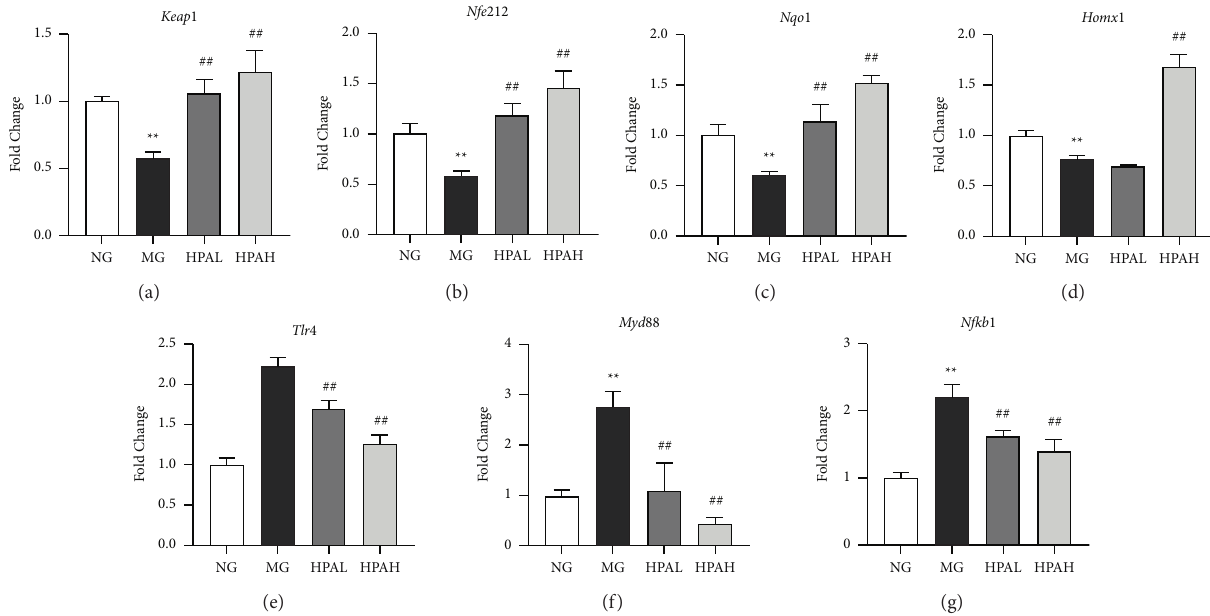
Figure 5: Effect of HPA on oxidative stress and inflammation-related gene expression in ALD mice. (a) Keap 1; (b) Nfe 2l2; (c) Nqo 1; (d)